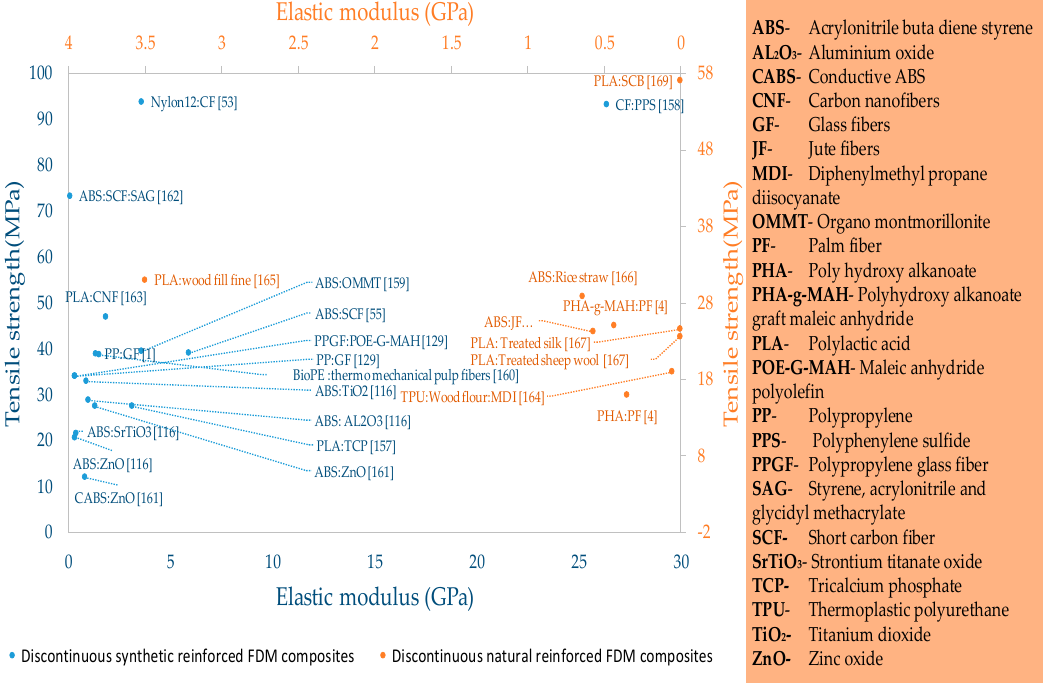
(Figure 14d) [162], and the other treats ZnO powder with an ABS:acteone solution to form a surface layer of ABS for compatibilizing with ABS matrix